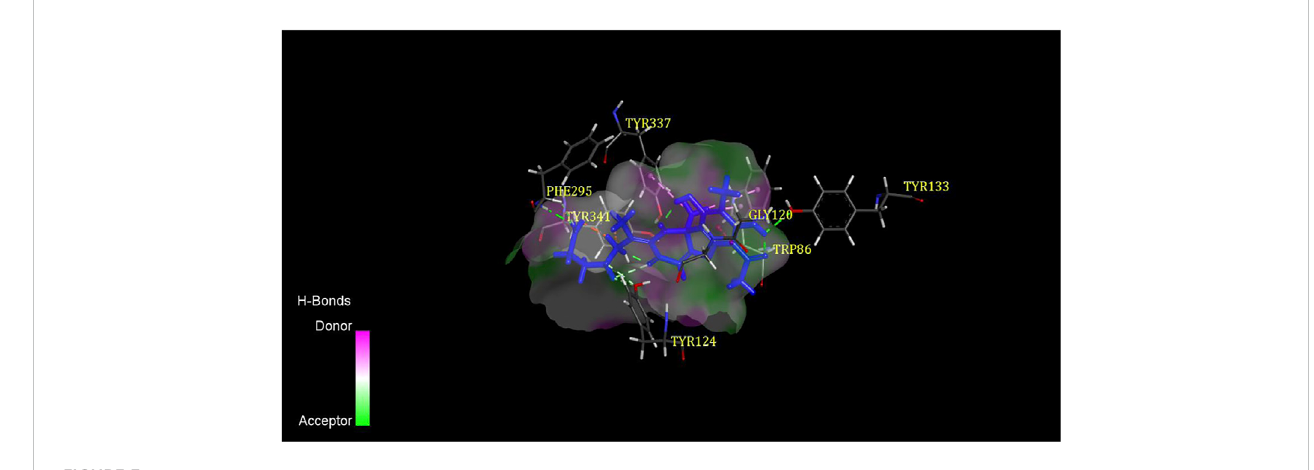
FIGURE 3 3D binding mode of compound 2 with AChE.